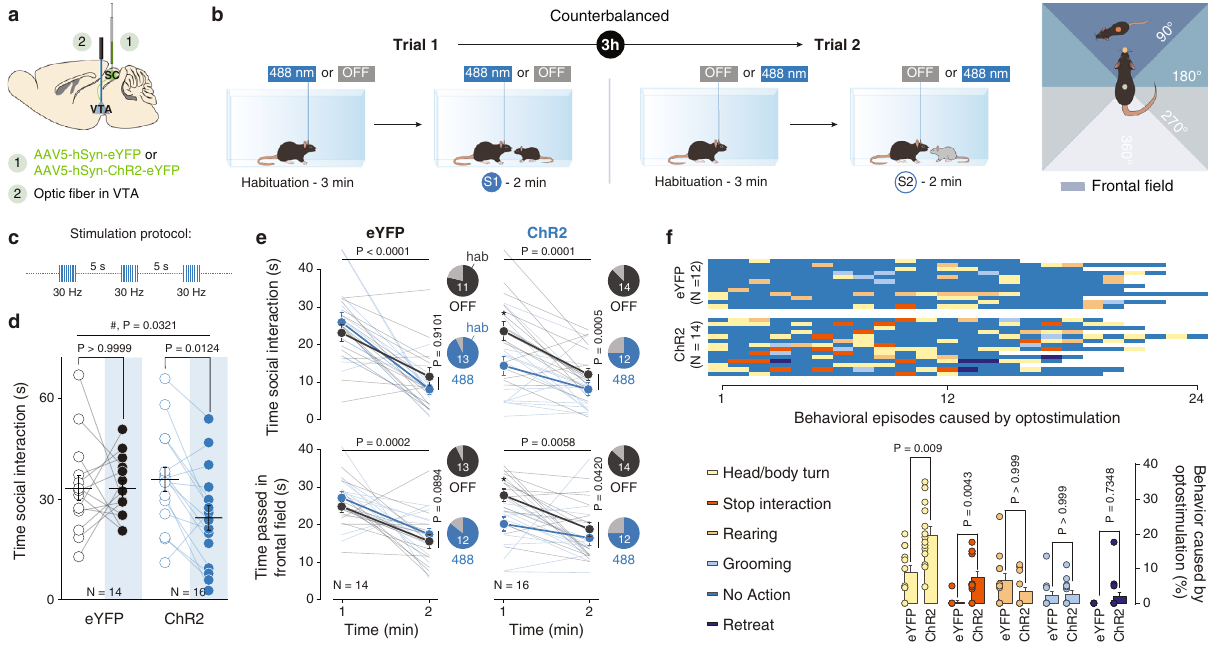
Fig. 5 Optogenetic manipulation of SC-VTA pathway alters social interaction and perturbs head orientation towards conspeci fi c. a Schema of injections sites in SC with AAV5-hSyn-eYFP or AAV5-hSyn-ChR2-eYFP, and optic fi ber implantation above the VTA. b Left panel: Schema of free social interaction. The eYFP- and ChR2-expressing mice freely interacted with two different unfamiliar mice under both stimulation conditions. Right panel: schema representing the position of the frontal fi eld. c Stimulation protocols: 8 pulses of 488 nm light (30 Hz) were separated by 5 s in the light ON condition. d Time social interaction during the free social interaction test for eYFP- and ChR2-expressing mice in the SC. RM two-way ANOVA (Light main effect: F (1,28) = 5.0855, P = 0.0321; Virus main effect: F (1,28) = 0.8528, P = 0.3637; Light × Virus Interaction: F (1,28) = 4.1962, P = 0.0500) followed by Bonferroni-Holm post-hoc test correction. e Upper panels: time passed interacting with the social stimulus for the 1st and 2nd minute of the free social